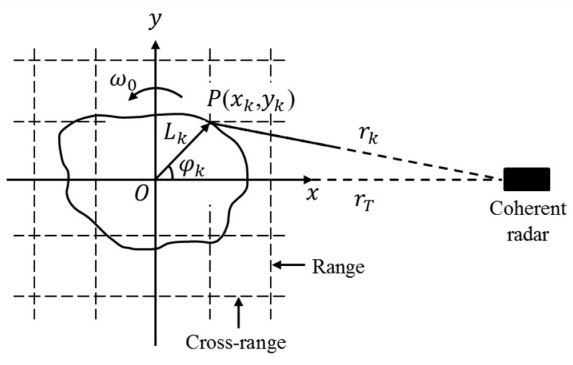
Figure 1. Rotating object